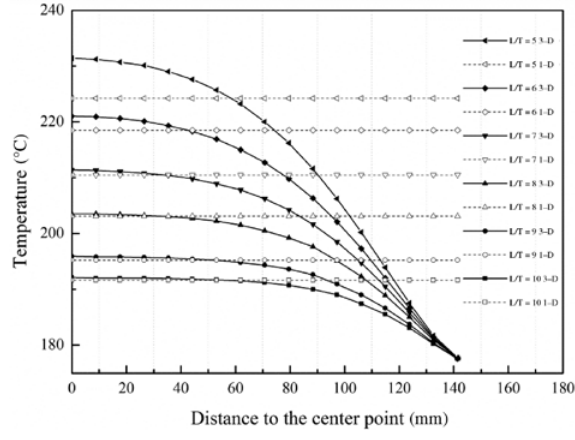
Figure 7: Temperature of laminates with different span-to-thickness ratios.